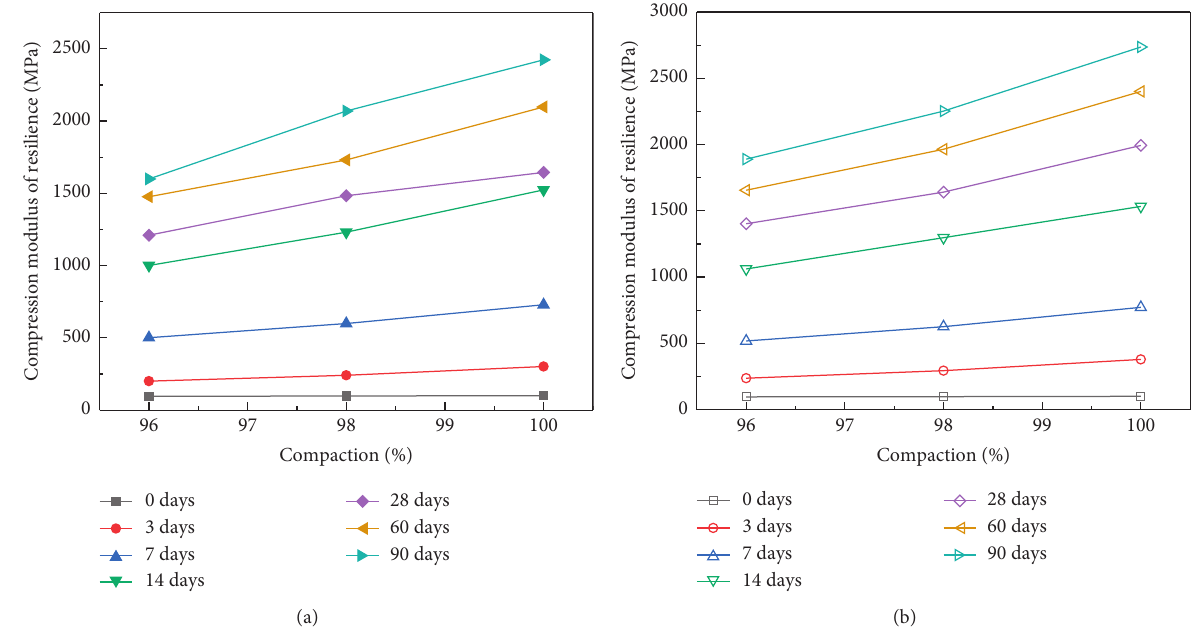
Figure 12: Effect of compaction degree on compression modulus of resilience. (a) GM gradation; (b) XM